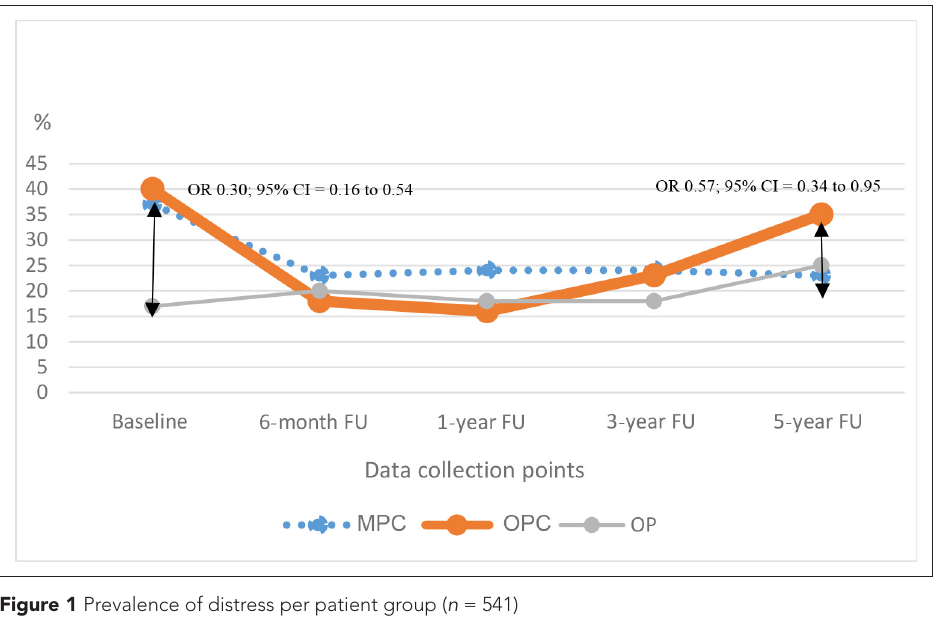
Figure 1 Prevalence of distress per patient group ( n = 541) CI = confidence intervals. FU = follow-up. OR = odds ratio.